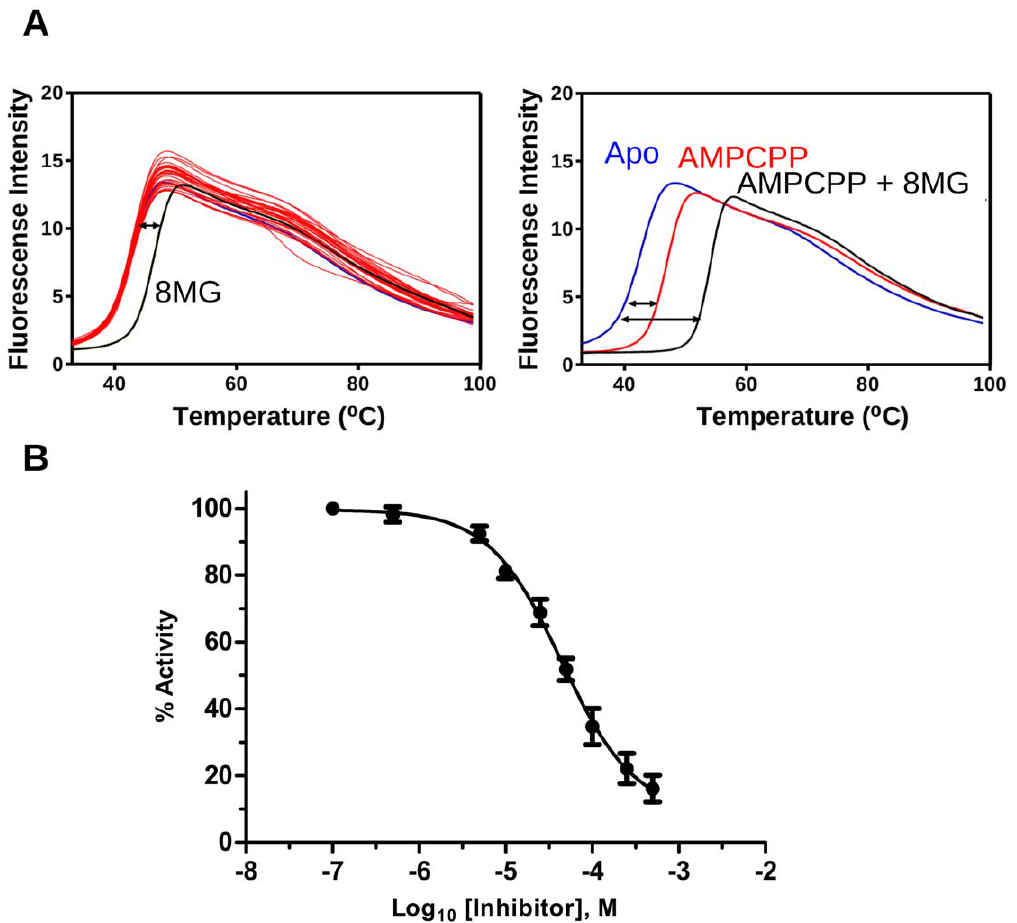
Figure 3. DSF and enzyme assays. A, Superposition of the DSF assay profiles of 37 ROCS compounds ( left ) showing the curve for 8- mercaptoguanine (8MG) (black) and thermal shift D T , double headed arrow) relative to the apo enzyme (blue) or relative to the AMPCPP complex ( right ). The DSF assay for AMPCPP is also shown (red). B, Dose response curves for the inhibition of SaHPPK by 8-mercaptoguanine (IC 50 =41 m M). HMDP and ATP concentrations were fixed at 0.3 m M and 0.2 m M respectively.